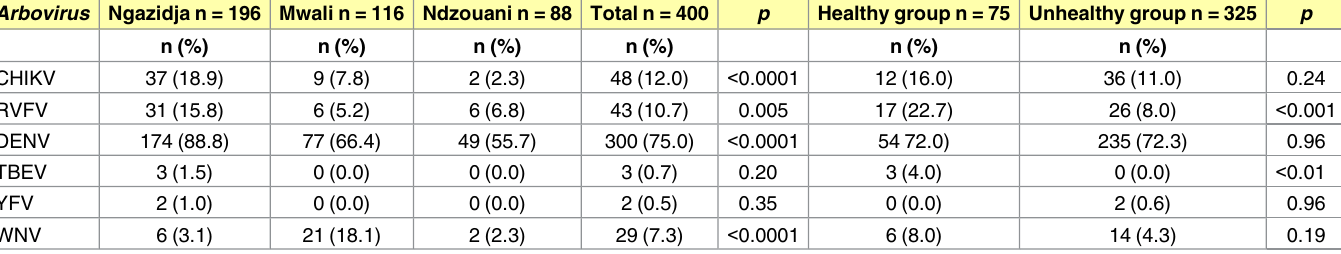
(12.0%, 10.7% and 7.2%, respectively). Finally, very few individuals were seropositive for TBEV and YFV (0.7% and 0.5%, respectively). When the data generated from individuals suf- fering clinical conditions (n = 325) and from healthy individuals (N = 75) were analyzed sepa- rately (Table 2), the prevalence rates were not statistically different between the two subgroups for DENV, CHIKV, YFV and WNV but were found significantly higher for RVFV and TBEV in the subgroup of healthy individuals. In addition to IgG serology that was carried out on the whole sample, there was enough residual serum to screen for the presence of IgM antibodies against DENV, CHIKV, WNV and RVFV viruses for 364 samples. Very few sera were found seropositive for IgM to DENV, WNV and CHIKV (3, 2 and 0 sera respectively) (Table 3). In contrast, higher rates of seroposi- tivity for IgM to RVFV were recorded in the three islands with the highest rates on Mwali (10.25%), and Ndzouani (8.04%) compared to Ngazidja (2.5%) (p < 0.05). IgG seropositivity rates to DENV A total of 300 sera tested positive through ELISA for IgG antibodies to DENV. This consisted of 174, 77 and 49 sera from Ngazidja, Mwali and Ndzouani, corresponding to 88.8%, 66.4% Table 2. IgG antibodies to each arbovirus according to living Island and to the status of serum donors (n = 400). The positivity criteria is a Absor- banceRatio to the cut-off value > 1.1.